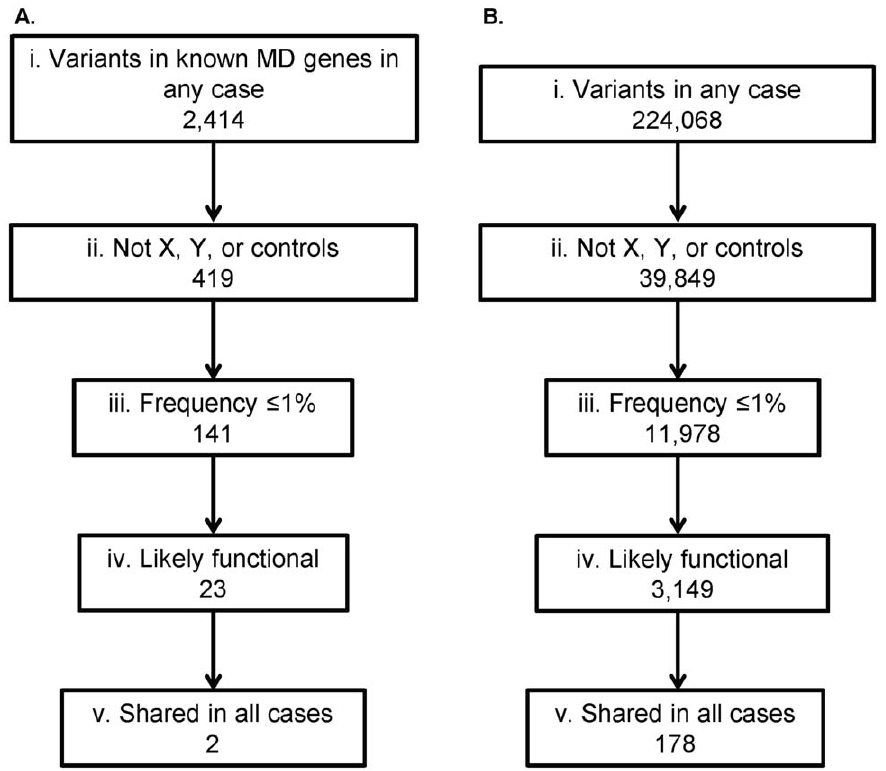
Figure 3. Filtering of variants identified through exome sequencing of individuals in LGMD2359. Variant filtration was performed for all variants (SNVs and indels) identified in known muscle disease genes (A) and in all genes (B). The total number of variants identified in any of the three cases (i) was restricted to variants that were not on the X or Y chromosomes and were not identified in any of the control individuals (ii). This list was further reduced to variants at # 1% frequency in the HapMap and 1000 Genomes Caucasian databases (iii), then to likely functional variants or variants within 10 bp of splice site (iv), and finally to variants that are shared in all 3 cases (v).